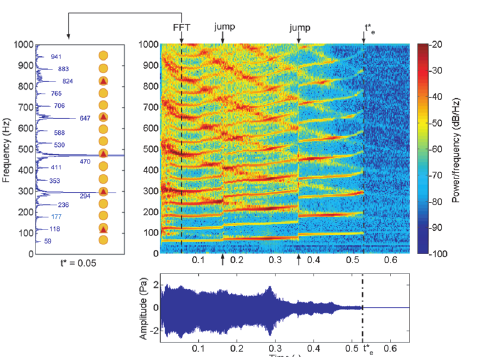
Figure 1. A typical spectrogram, signal and FFT plot [2], fea- turing the falling air and rising structural resonance and sudden jumps. Note that time has been non-dimensionalised by the to- denotes the abrupt cessation of the tal discharge time and time t ∗ e sound, just past halfway through the